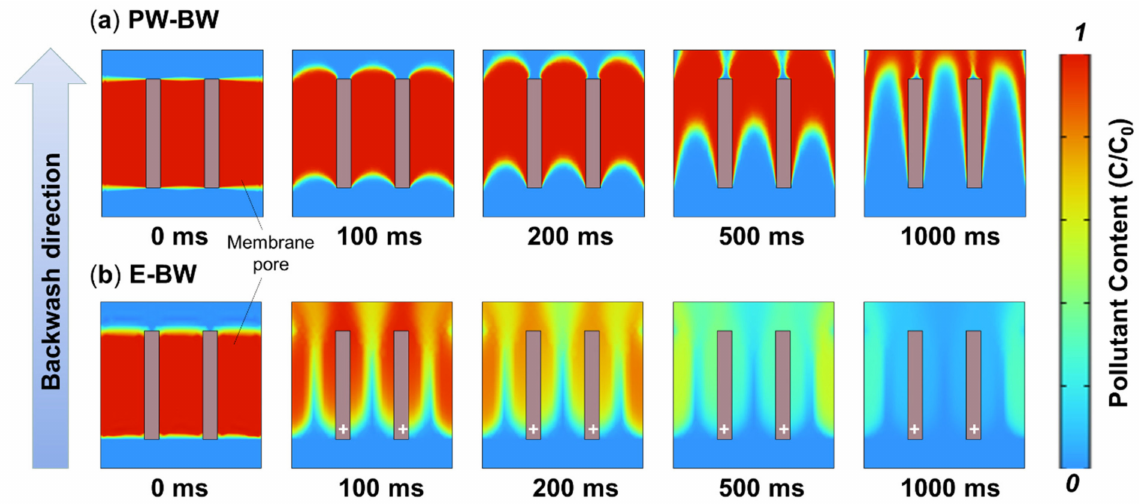
Figure 6. Simulation results obtained by FLUENT. Conditions and parameters can be founded in Section